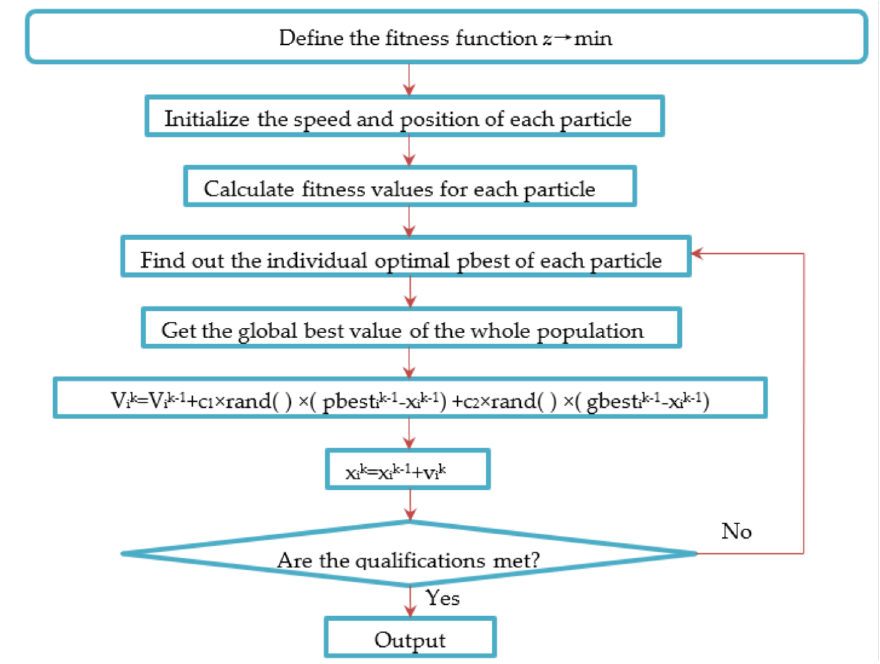
Figure 9. Flow chart of particle swarm optimization.